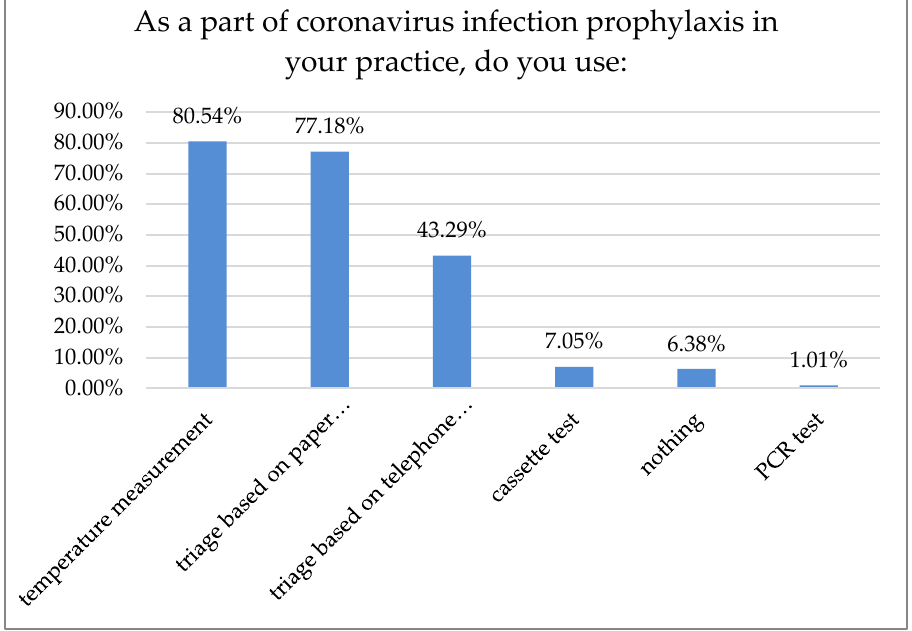
Figure 9. Coronavirus precautions in place of practice. Table 2. Sleep quality before and during the pandemic. No sex effect on sleep quality before and after the pandemic was observed. However, there was a significant time effect and sex × time interaction. The decrease in sleep quality among women was more significant compared to men (Table